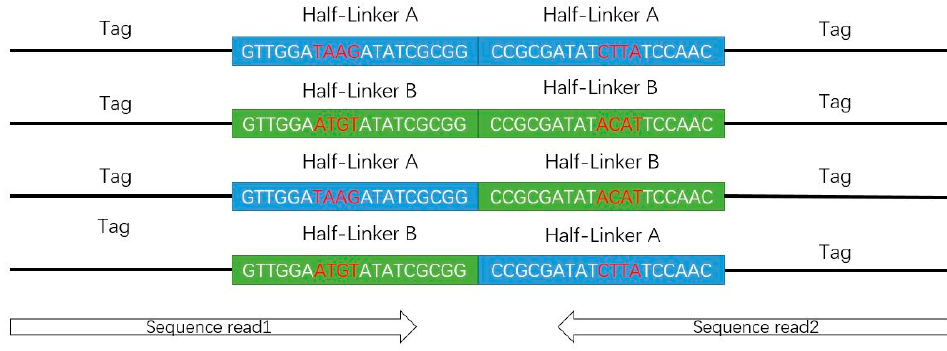
Figure 4. Deoxyribonucleic acid constructs from the experiments in tag-linker-tag format.